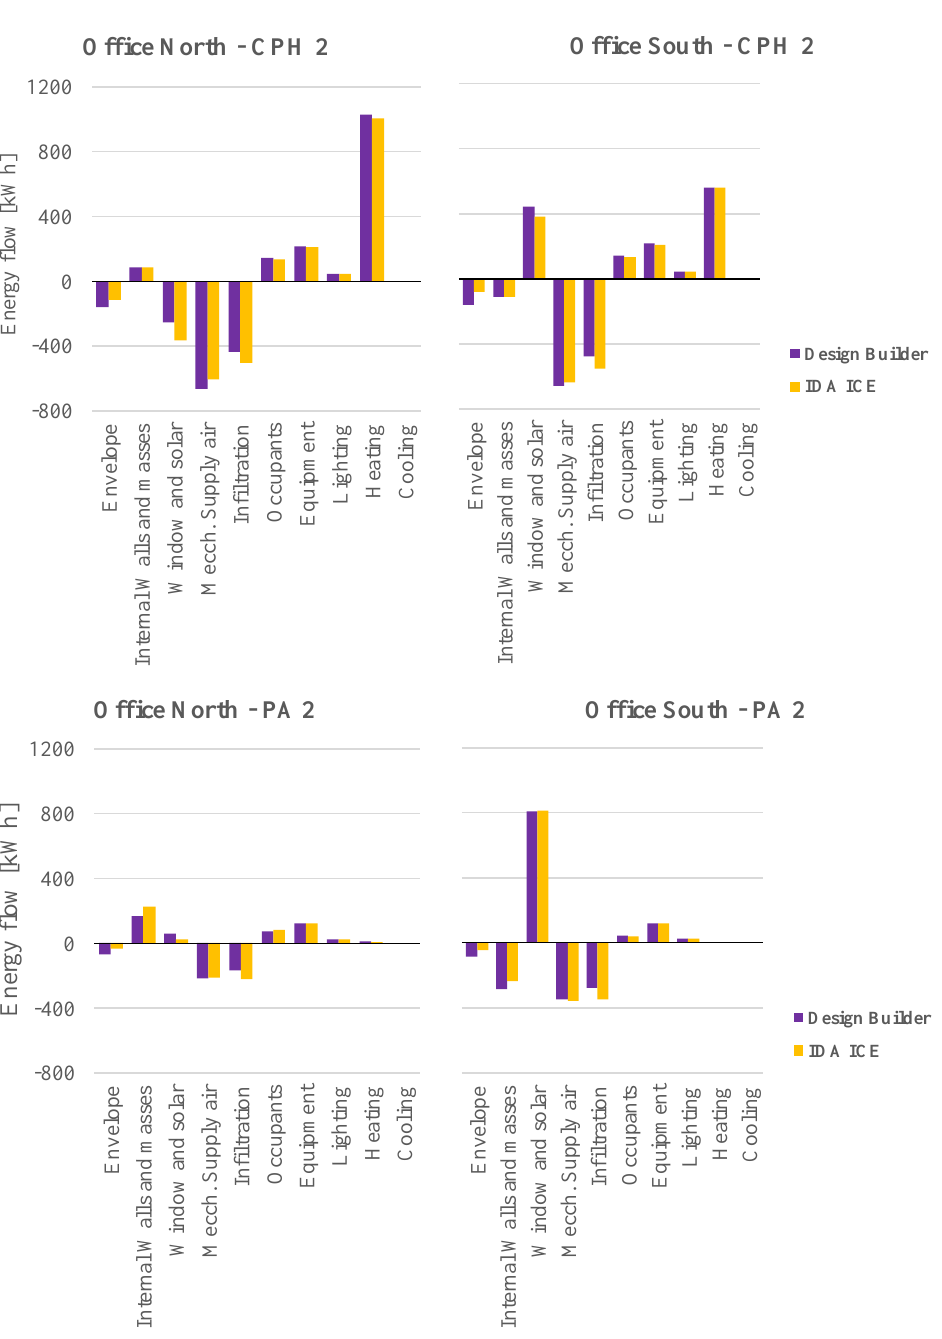
Figure 9. Energy flows for Copenhagen (up) and Palermo (down) in scenario 2 during the heating season.